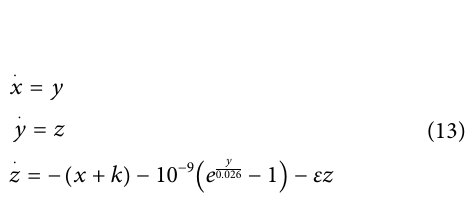
FIGURE 4 | The phase diagrams in 3D and 2D ( x-y plane) with the initial conditions of ( x 0 , y 0 , z 0 ) = (0, 0.4, 0) (red) and ( x 0 , y 0 , z 0 ) = (0, − 0.4, 0) (blue), and different values of ε : (A) 0.5; (B) 1.2; (C) 1.3.